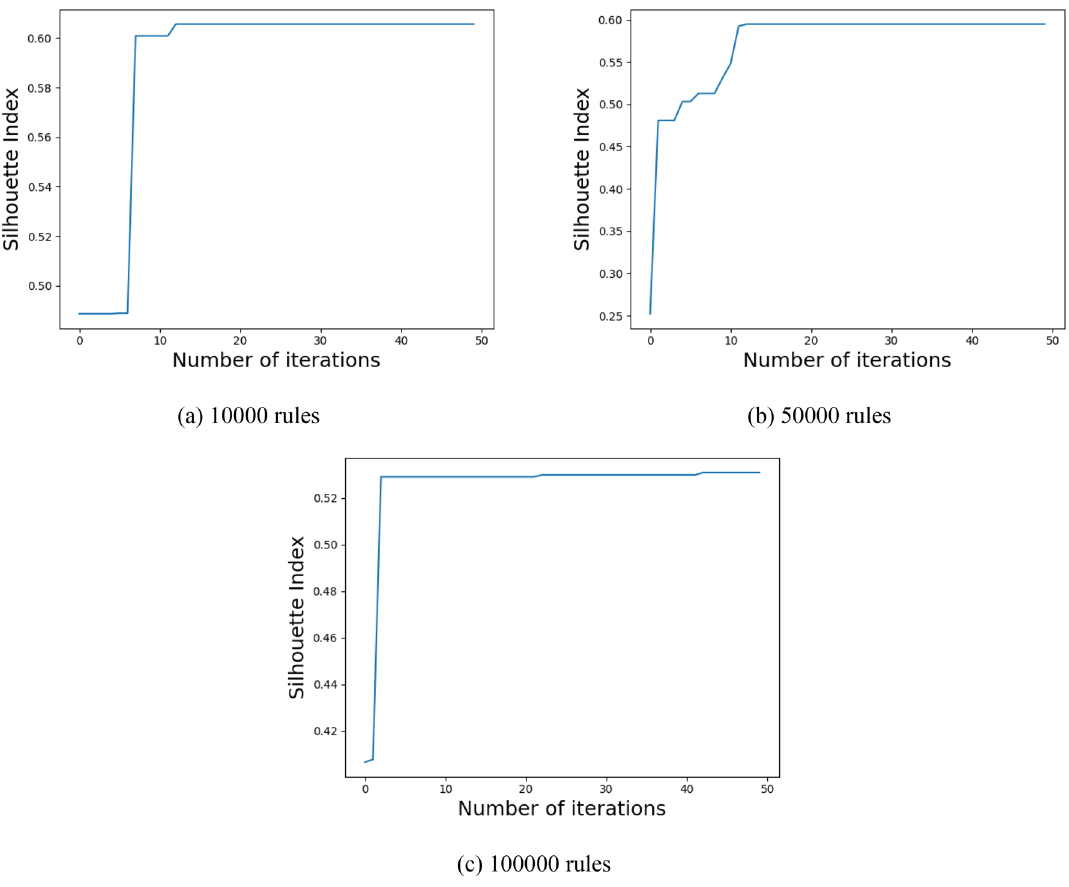
Figure 10. Parameter optimization on VMS policy